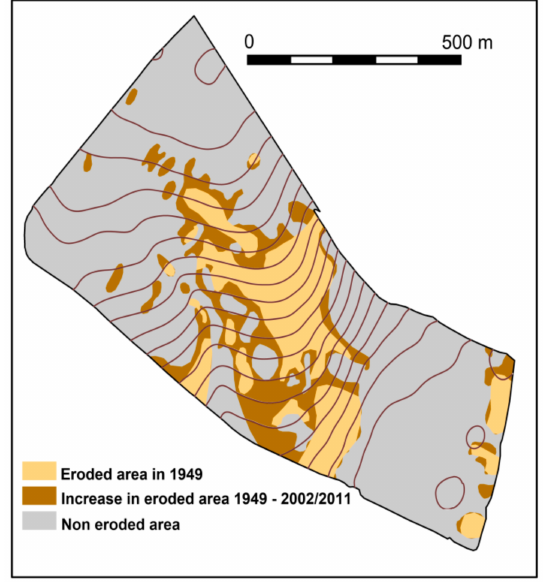
Figure 3. Increase in erosion areas from 1949 to 2002 /